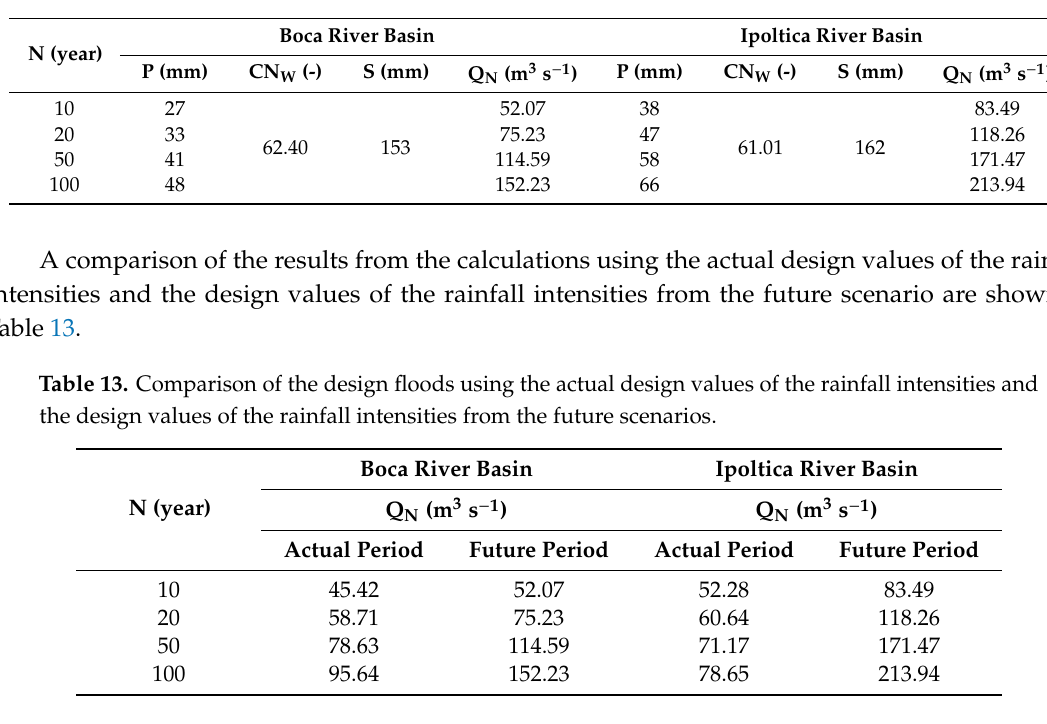
Figure 14. The future downscaled design rainfall intensities for the Liptovska Tepli č ka climatological station.